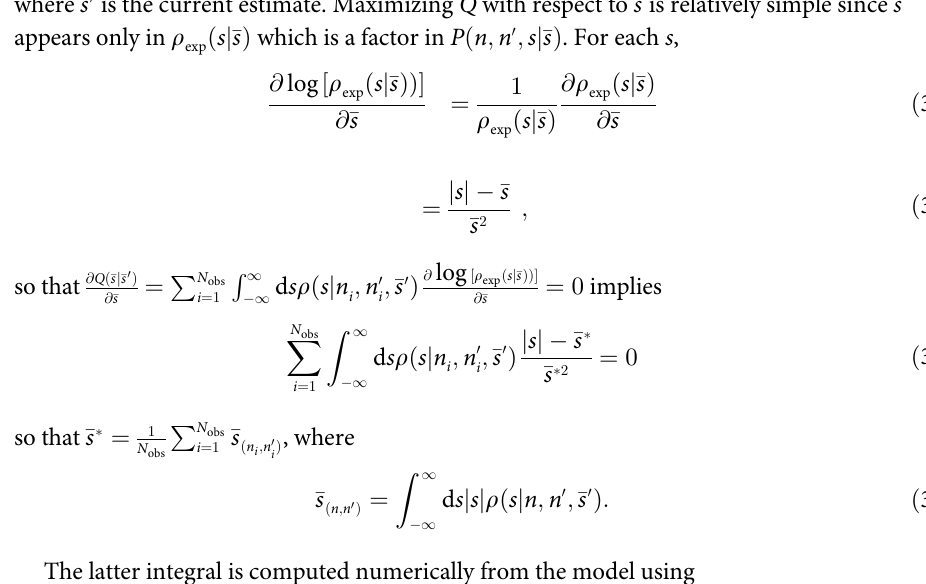
S1 Fig. Reinferring null model parameters. Shown are the actual and estimated values of the null model parameters used to validate the null model inference procedure over the range exhibited by the data. A 3x3x3x3 grid of points were sampled and results collapsed over each parameter axis. f was fixed to satisfy the normalization constraint. min S2 Fig. Dependence of conditional distribution P ( n 0 = 0| n ) on n . Two-step negative binomial to Poisson model captures tail better than one-step negative binomial model. Poisson model fits poorly. (Example donor S2-day 0 replicate pair). S3 Fig. Competition between ν and � s in shaping the posteriors, ρ ( s |0, n 0 ). A) Posteriors for n 0 = 9 over a range of ð � s ; a Þ pairs spanning the ridge shown in the inset in (B) and Fig 7 along which the growth of � s leads to ρ ( f ) overwhelming ρ ( s ) as the dominant explanation for s observed expansion. (B) The posterior mean versus � s for values of n 0 = 1, . . . , 9, with the 5 val- ues of � s used in (A) shown for n 0 =